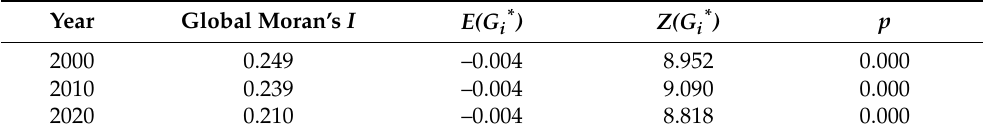
Table 5. Global Moran’s I of carbon emissions in the YRB in 2000, 2010, and